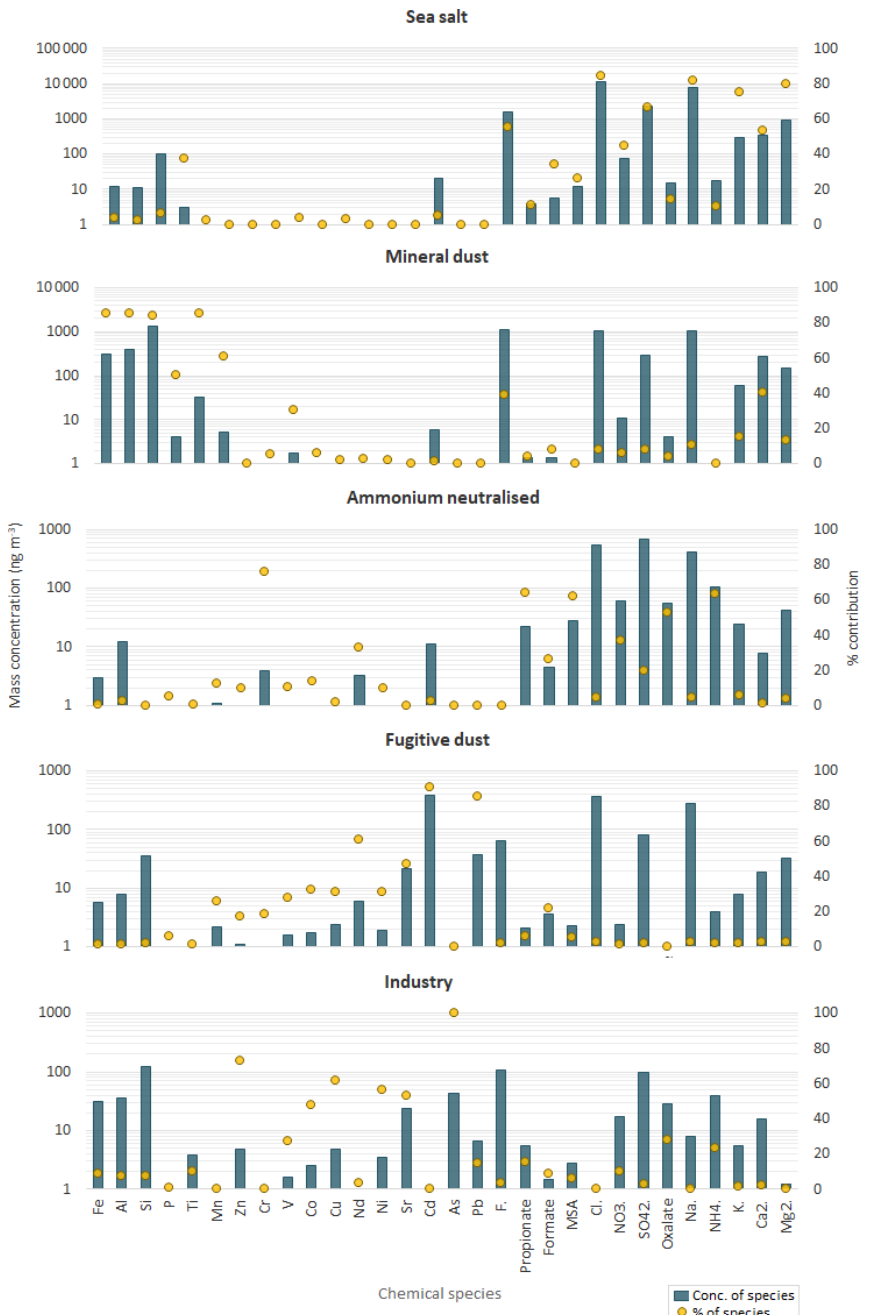
Figure 6. Profiles of the five components identified by the PMF analysis. Blue bars denote the mass concentrations of individual ele- ments/ionic species (left logarithmic axis, ngm − 3 ), while the yellow points indicate the percent of species attributed to the source (right